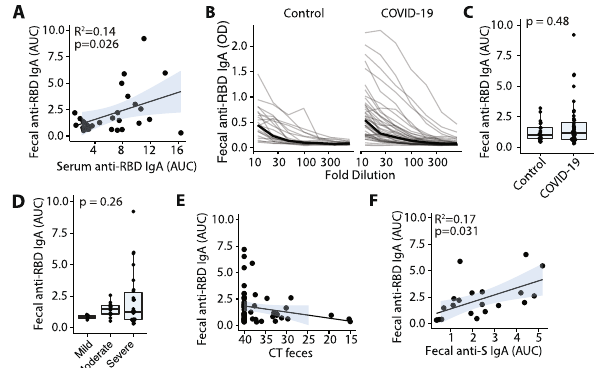
Figure 5. SARS-CoV-2-specific IgA in stool of COVID-19 patients. ( A ) Fecal and serum anti-SARS-CoV-2 RBD IgA are correlated. ( B , C ) Relative titers of anti-SARS-CoV-2 S1 RBD IgA in feces of control and COVID infected individuals. ( D ) Relative titers of anti-SARS-CoV-2 S1 RBD IgA in feces of COVID infected individuals with varying disease severity. ( E ) Anti-SARS-CoV-2 S1 RBD IgA and viral load are not correlated. Each point shows data from a single sample. ( F ) Anti-SARS-CoV-2 S1 RBD IgA and anti-S1 IgA in feces are correlated. Each point shows data from a single